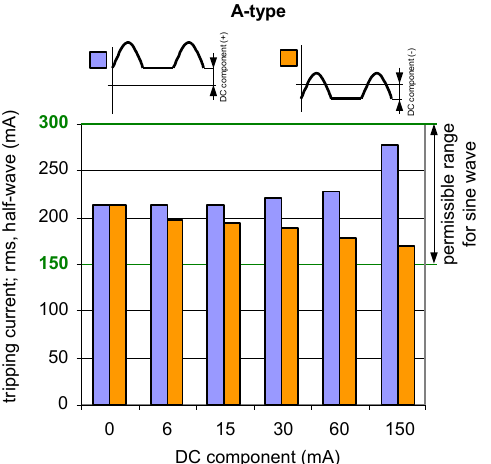
Figure 11. Tripping current (rms value of the DC pulsating component) of a 300 mA A-type RCD (symbol RCD300_2) under pulsating DC (half-wave) current superimposed by smooth DC component of values 6, 15, 30, 60, and 150 mA. Note—the smooth DC component may have a positive (+) polarity (left-side bars) or a negative ( − ) polarity (right-side bars).